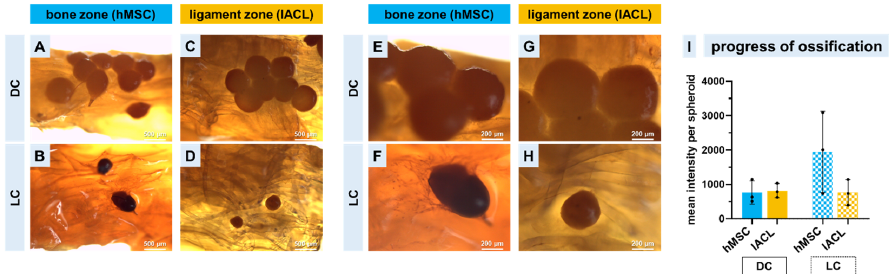
spheroids within the stained scaffolds was evaluated by measurement of the mean red intensity per spheroid ( I